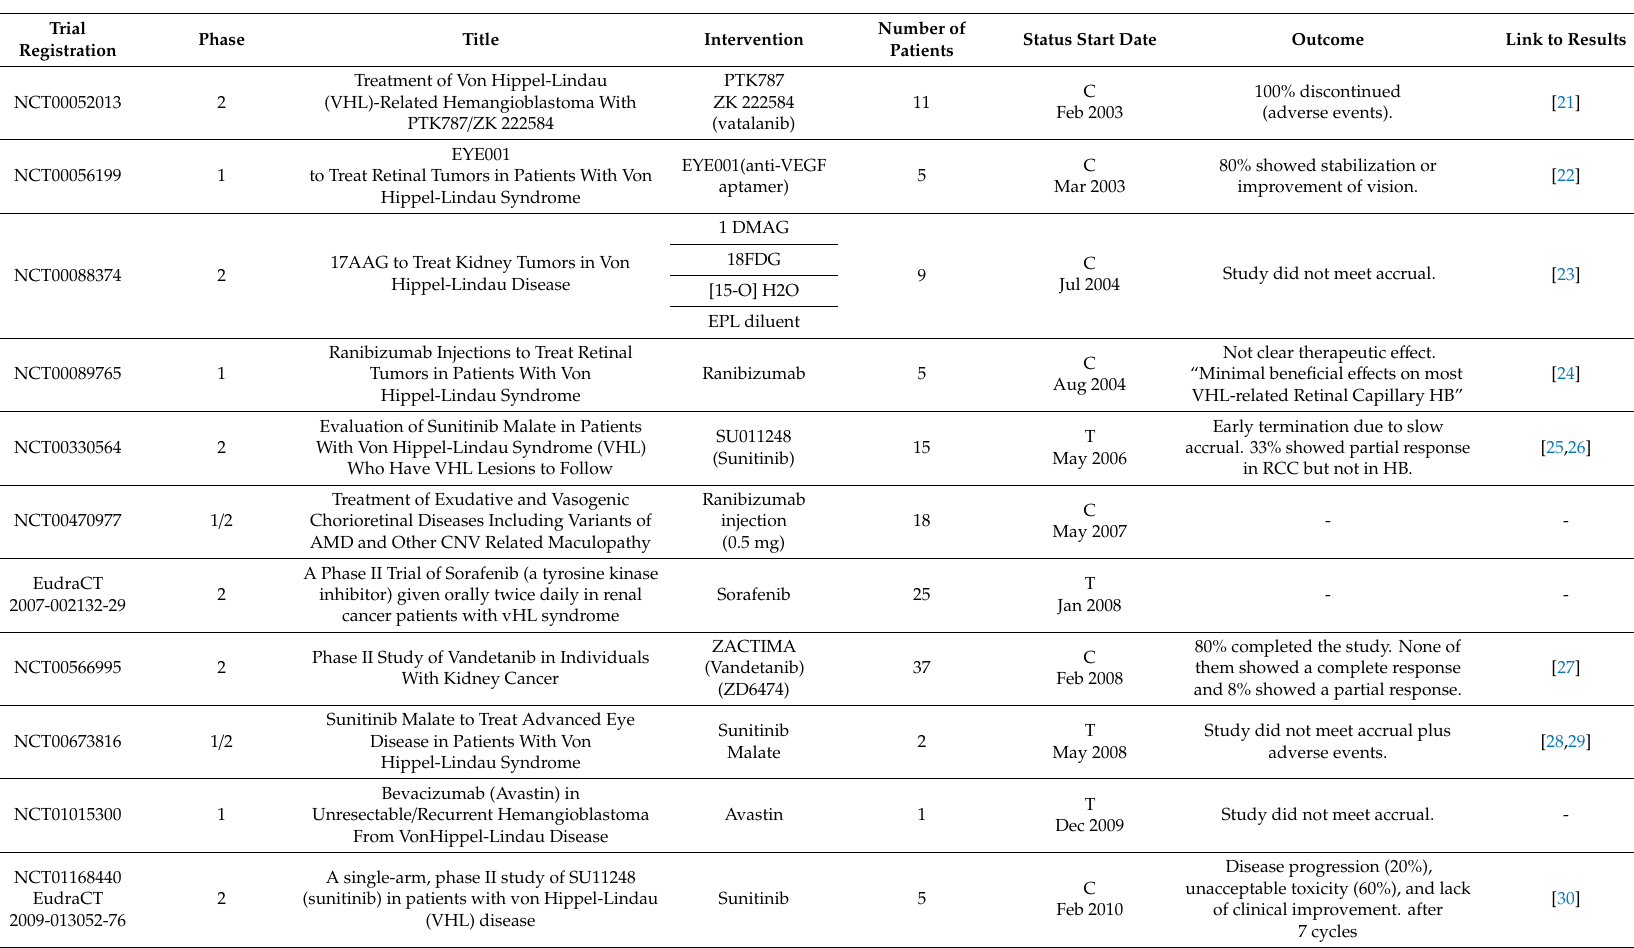
Table 1. Compilation of the VHL interventional clinical trials registered at the EU Clinical Trials Register (EudraCT) (https: // www.clinicaltrialsregister.eu) and the U.S. National Library of Medicine (NCT) (https: // clinicaltrials.gov). Only interventional trials whether a therapeutic drug was tested are listed. All the trials showed here were designed as single-arm, open-label trials. Abbreviations: Status: C (Completed); R (Recruiting); O (Ongoing); T